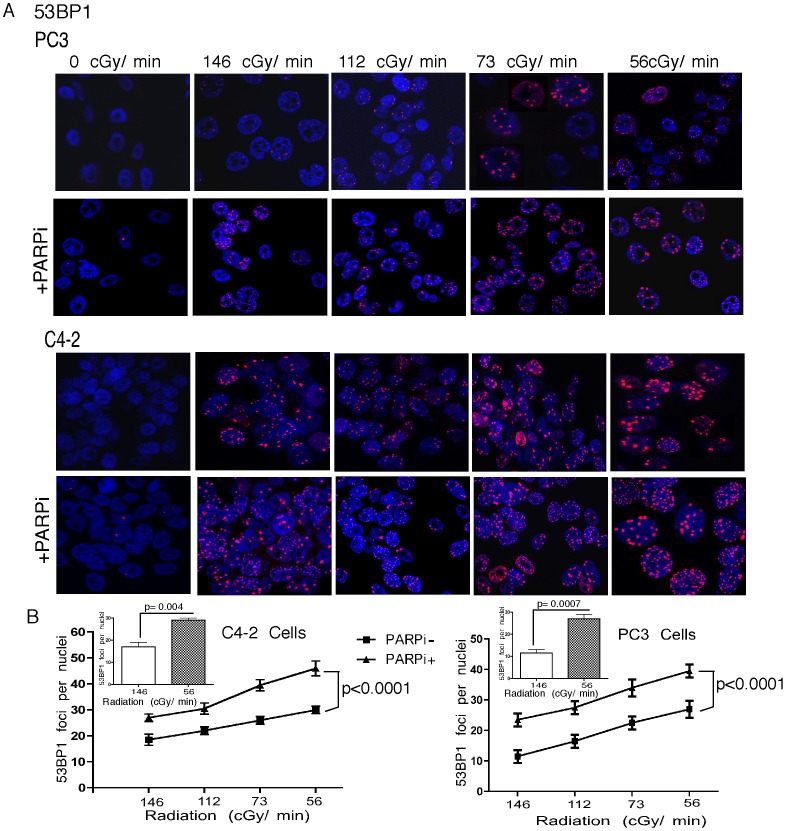
LDR, when combined with rucaparib, augments DNA damage-induced 53BP1 IRIF.
A, Confocal immunostaining of 53BP1 foci in PC3 and C4-2 cells following radiation at the indicated dose rates. B, Graphical representation of dose-dependent 53BP1 IRIF generation. Error bars represent SD of mean (n = 3).